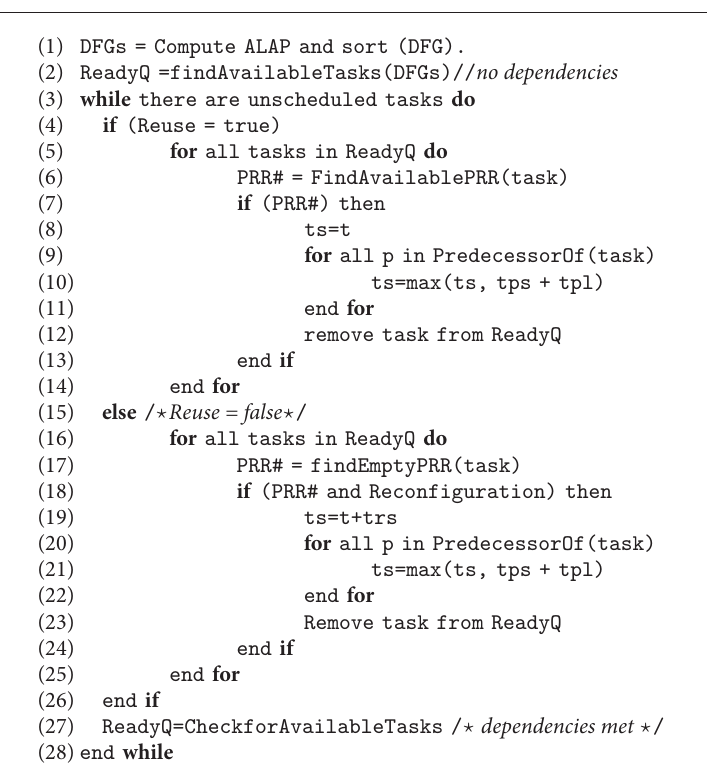
Algorithm 1: Pseudo-code for